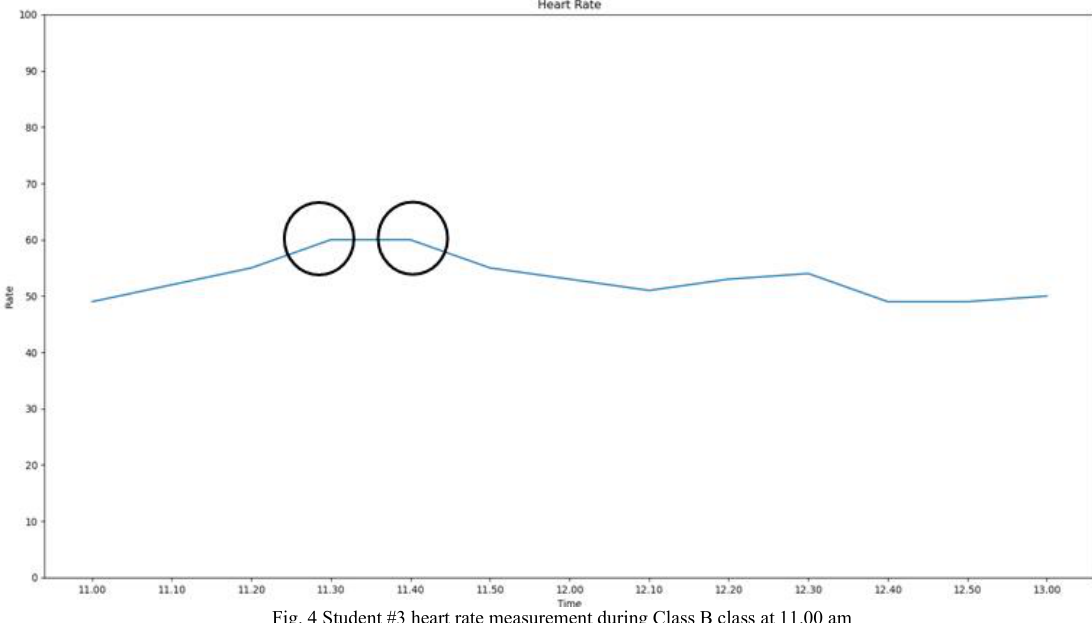
Fig. 4 Student #3 heart rate measurement during Class B class at 11.00